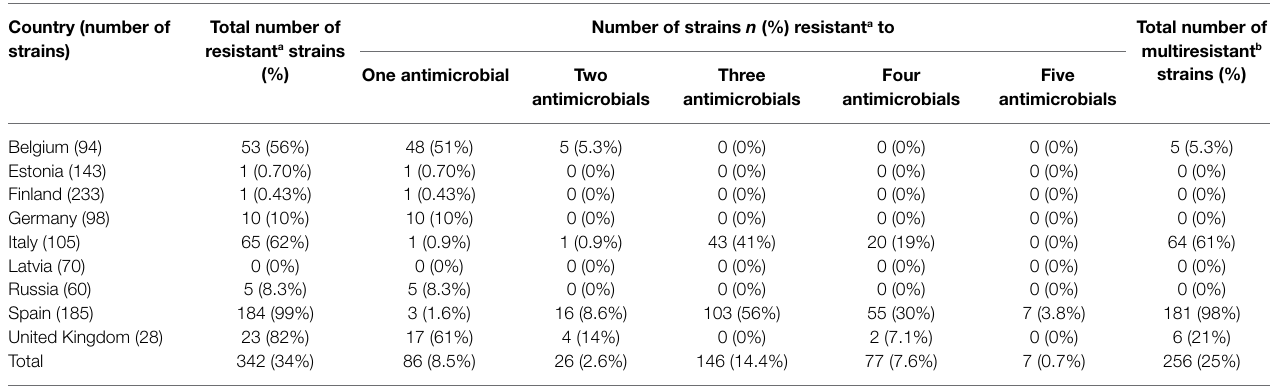
TABLE 2 | Antimicrobial resistance of porcine Yersinia enterocolitica 4/O:3 strains in nine European countries. Country (number of strains)